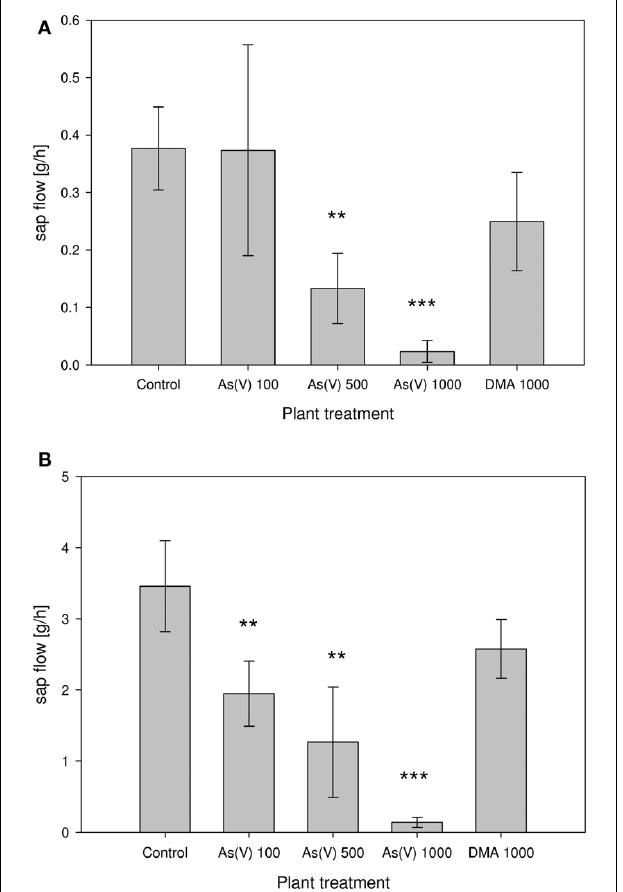
FIGURE 3 | Sap flow of decapitated cucumbers of plant set B (Figure 3A) and C (Figure 3B) after challenge of plants withAs V at 100,